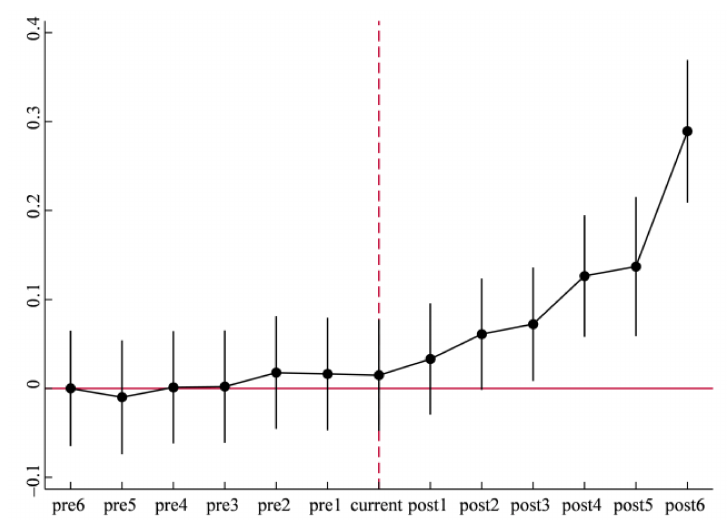
Figure 1. Parallel trend testing.